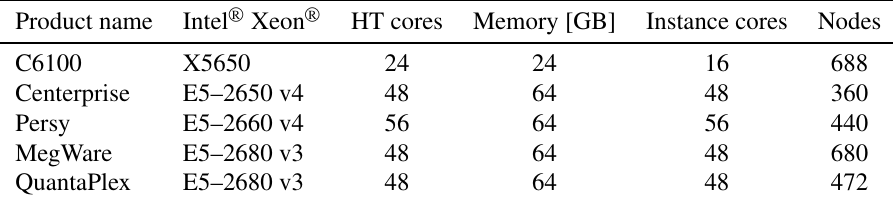
Table 1. The hardware at P1 currently available for use with Sim@P1. The C6100 nodes are the decommissioned old HLT. They provide 11008 hyper-threaded (HT) cores permanently running in o ffl ine mode. Not all cores are used to ensure the virtual machines provide su ffi cient memory for ATLAS o ffl ine workloads. The other hardware is switched to o ffl ine mode when data taking is not foreseen in the next 24 hours. These opportunistic resources provide up to 97216 additional cores. Usually the trigger and data acquisition team retains some resources for their